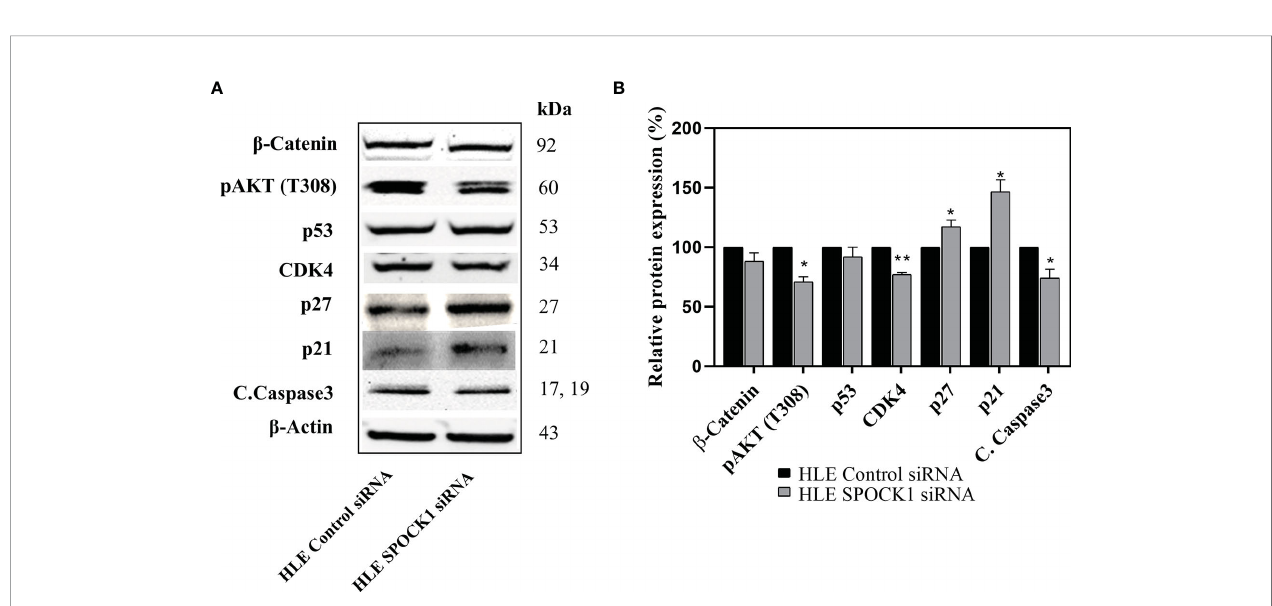
FIGURE 10 | Western blotting of control and SPOCK1 siRNA silenced HLE cells. (A) Additional consequences of SPOCK1 downregulation. Inhibition of the proteoglycan resulted in the downregulation of pAkt (T308), and CDK4 cyclin-dependent kinase, accompanied by the elevated expression of p21 and p27 cyclin- dependent kinase inhibitors. (B) Quantitative evaluation. *p < 0.05, **p <